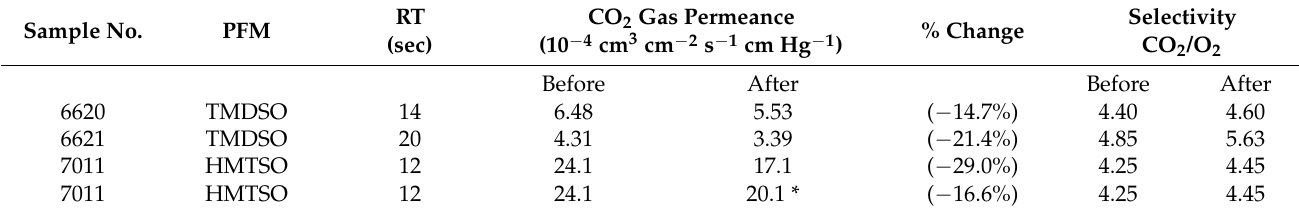
Table 14. Effect of heat aging at 90–100 °C for 90 min on gas permeance of membranes made from TMDSO and HMTSO plasma polymers.